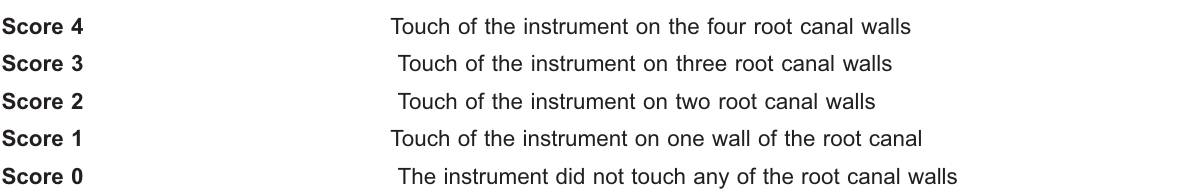
TABLE 1- Scores attributed to instrument touching on the root canal walls